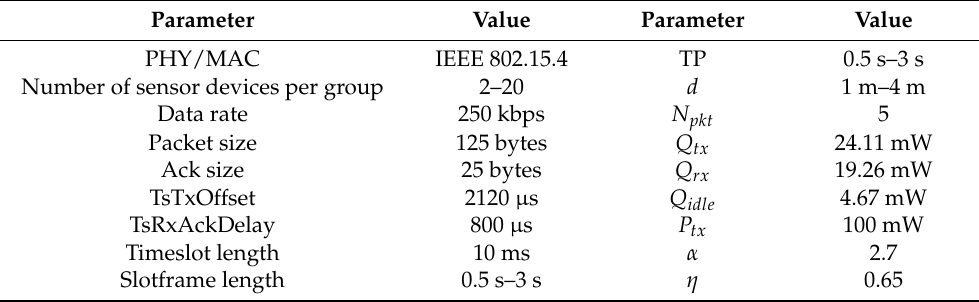
Table 1. Simulation